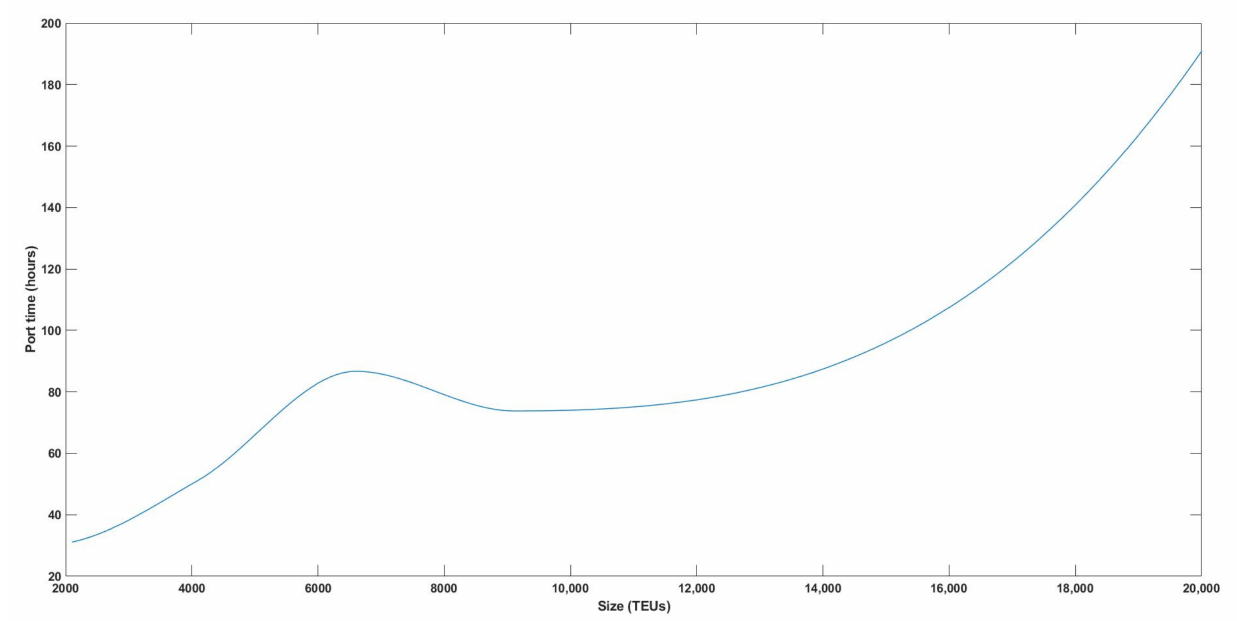
Figure 2. Port time TP(SS) as a function of ship size